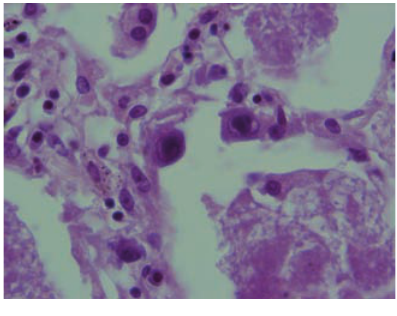
Figure 1. Lung, intranuclear cytomegalo- virus inclusion body (Hematoxylin & Eosin ×400).